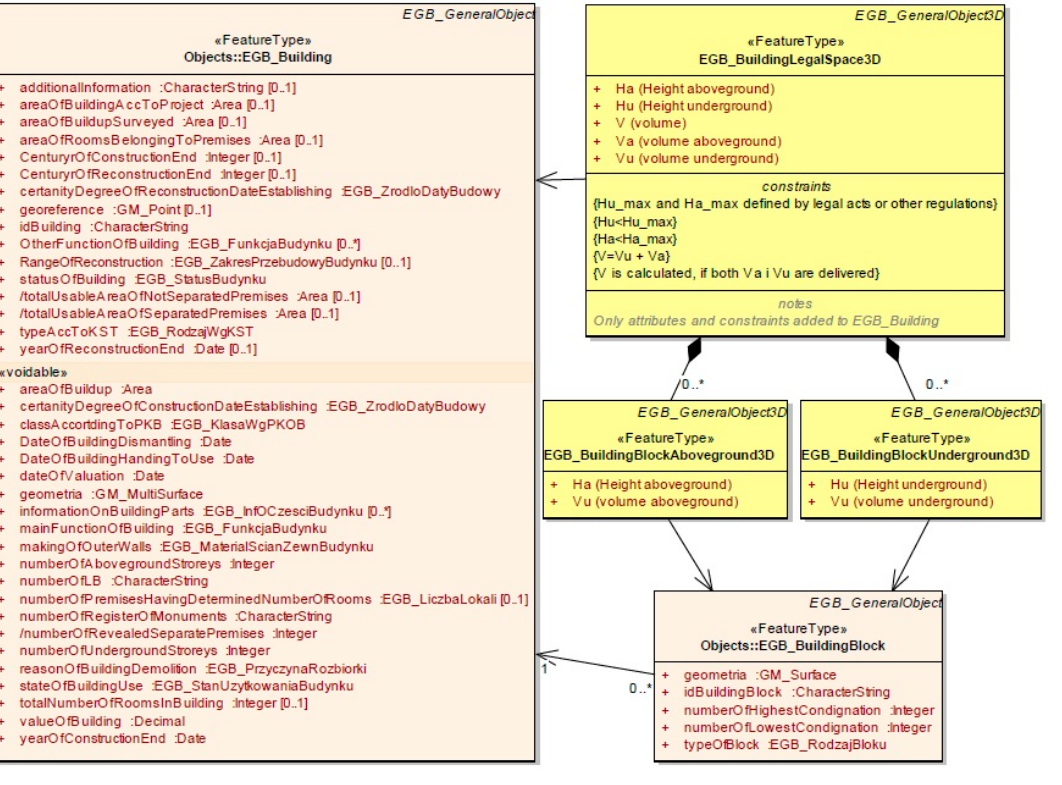
Figure 10. Model of relationships between classes representing 2D and 3D building objects.